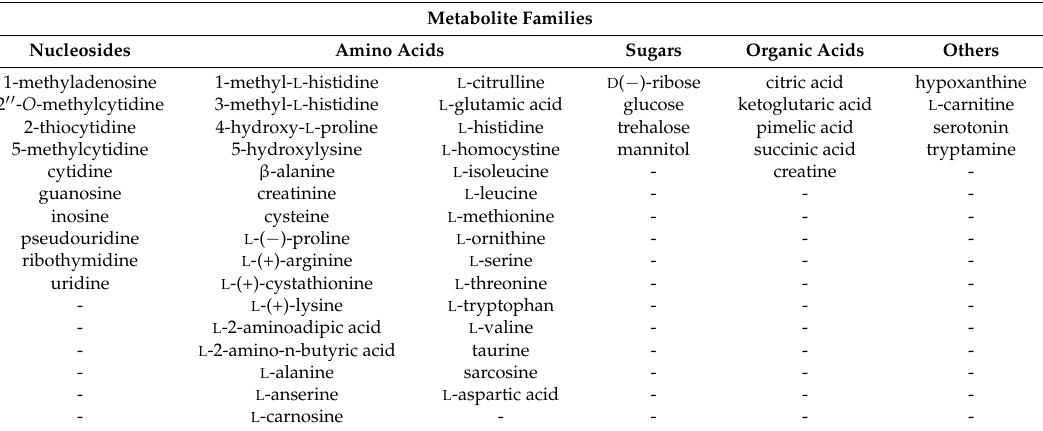
Table 1. Metabolites contained in the analyzed mixture.